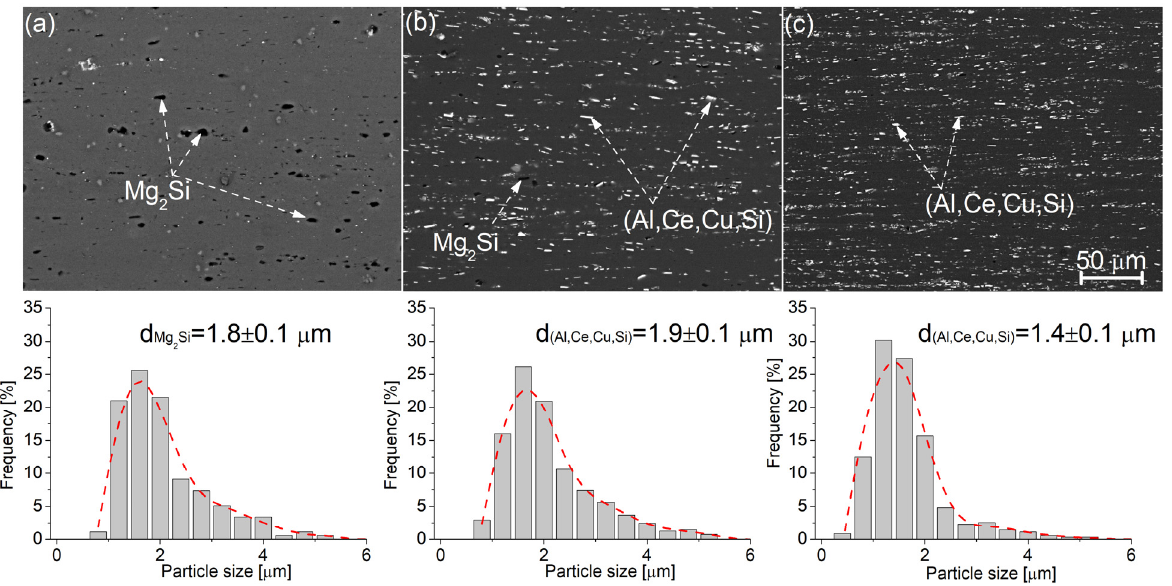
Figure 4. SEM-BSE images of the studied alloys in the as-cold rolled state and corresponded particle size distribution histograms.